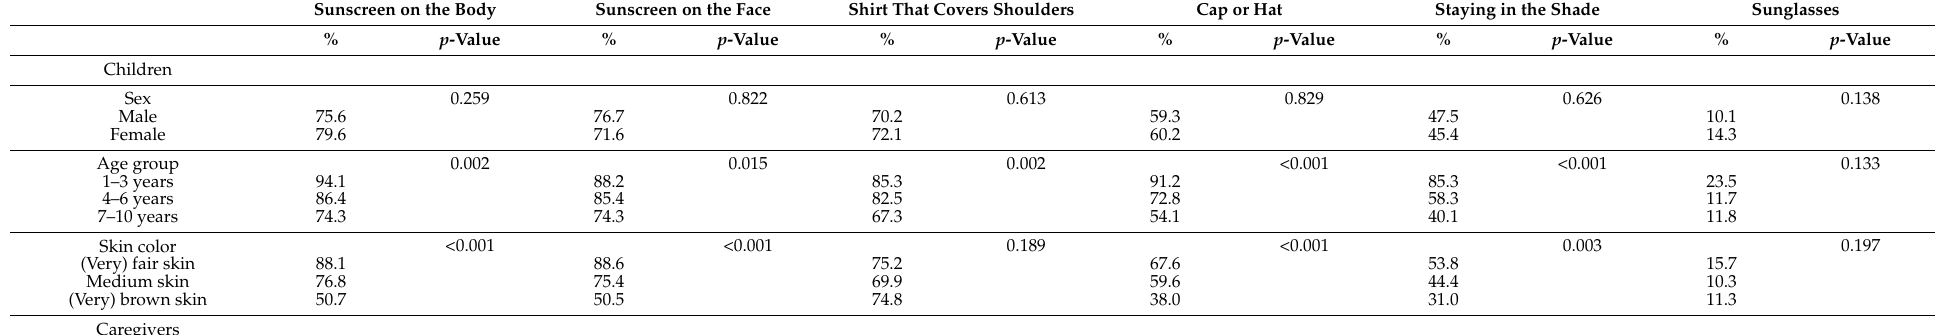
Table 2. Determinants related to the use of sun protection measures based on answers of 554 participants in wave 2020 of the National Cancer Aid Monitoring (NCAM). Sunscreen on the Body Sunscreen on the Face Shirt That Covers Shoulders Cap or Hat Staying in the Shade